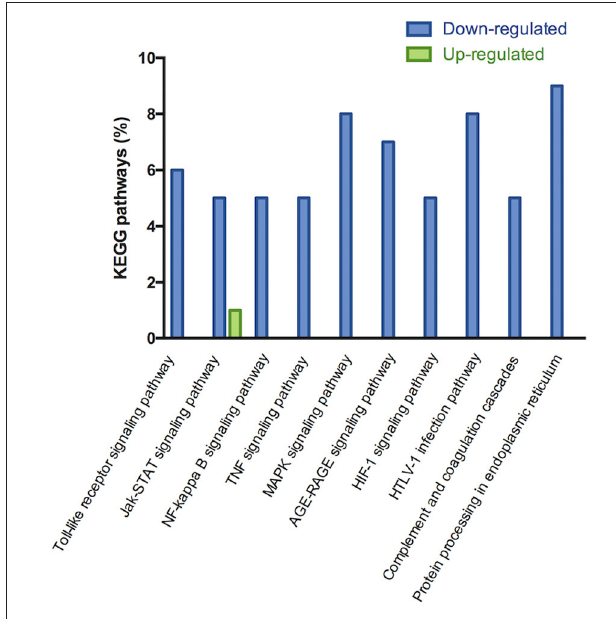
FIGURE 5 | KEGG pathway analysis of up and down regulated genes with a fold change of at least 2 in the dogs of MI + LLVNS group ( n = 5) compared with MI group ( n = 6). KEGG, Kyoto encyclopedia of genes and genomes; LLVNS, low level left vagus nerve stimulation; MI, myocardial